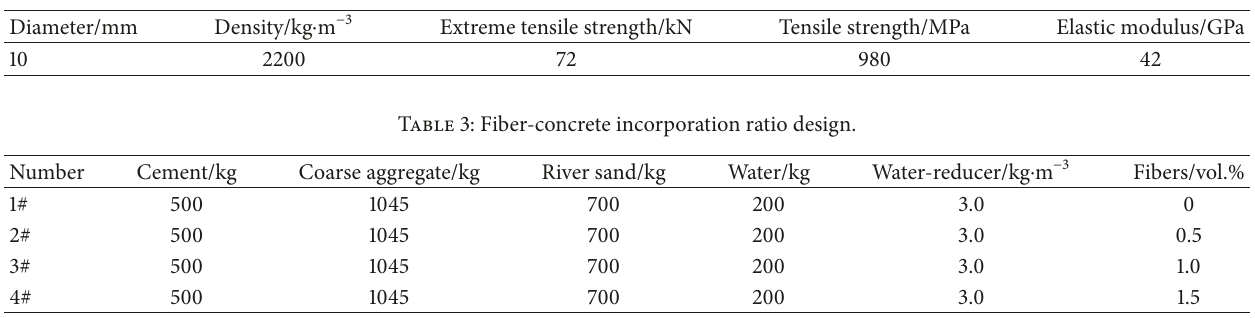
Table 2: Mechanical parameters of GFRP bar.